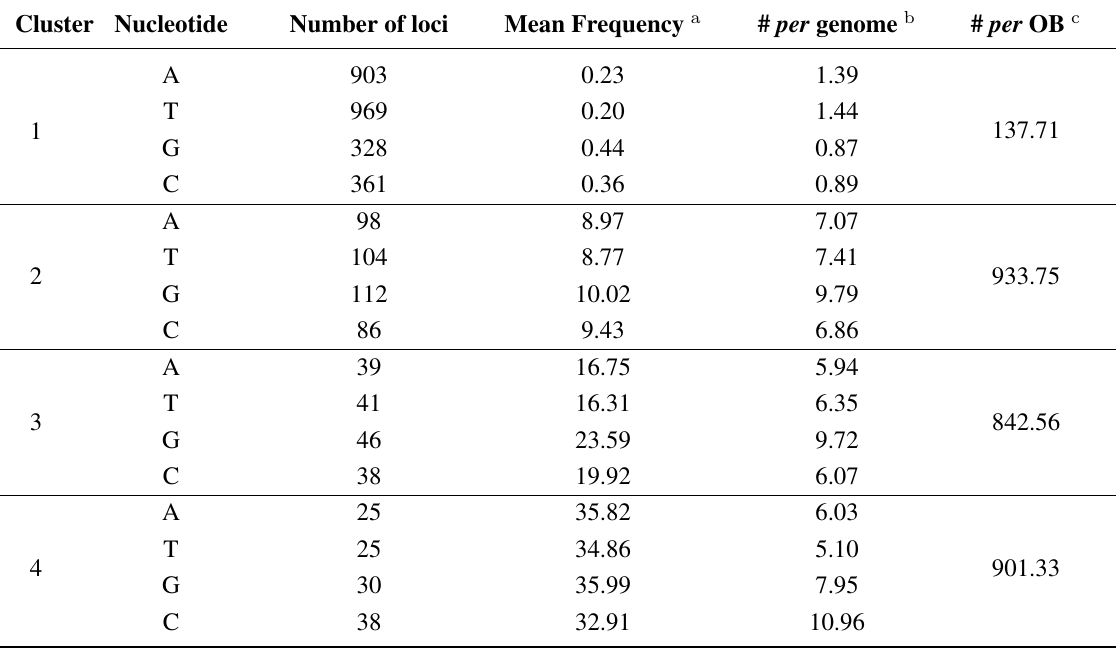
Table 2. Statistics of the non-consensus SNP clusters.